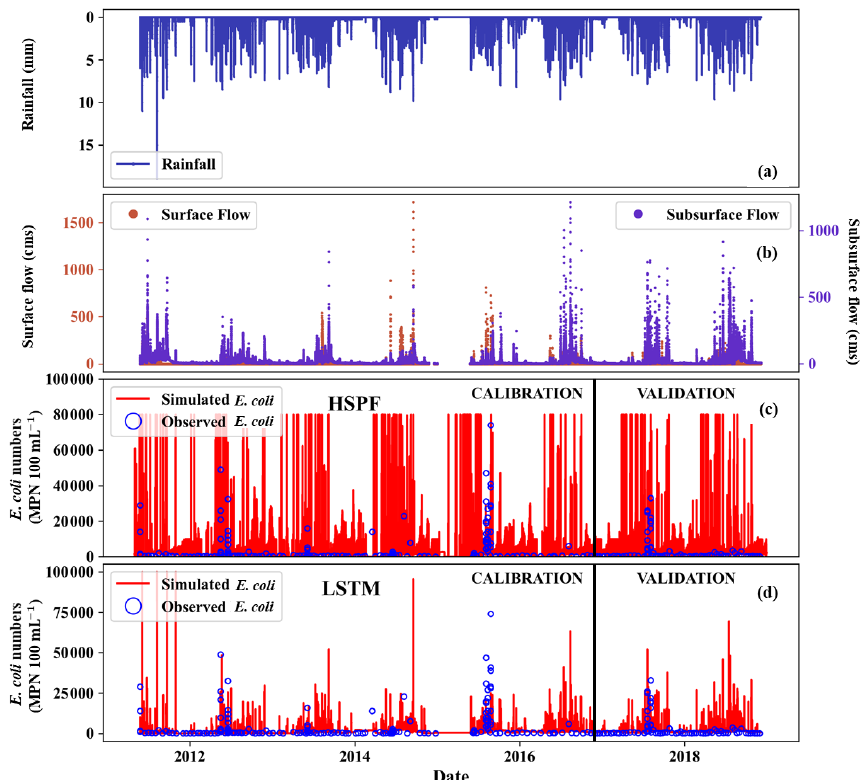
Figure 6. E. coli simulation from LSTM and HSPF: (a) measured rainfall, (b) observed surface and subsurface flow, (c) simulated and observed E. coli concentration using HSPF, and (d) simulated and observed E. coli concentration using